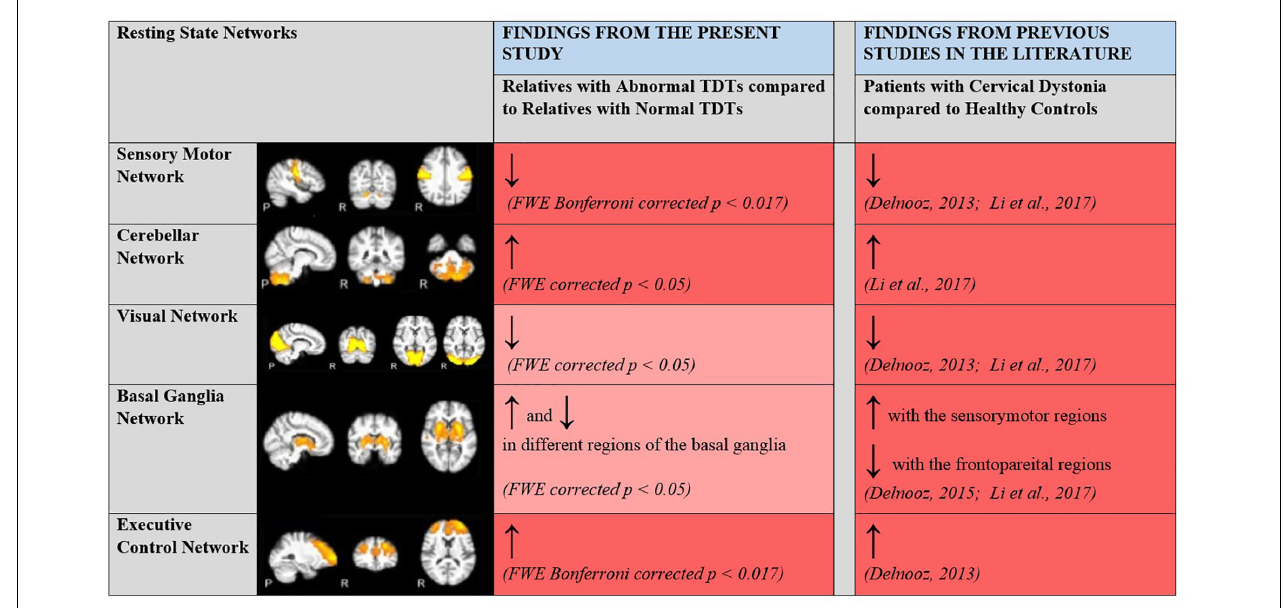
FIGURE 5 | Changes in within network functional connectivity in relatives with abnormal TDT when compared to relatives with normal TDT. Comparative analyses with previous rsfMRI connectivity studies carried out with patients with CD and healthy controls. ↑ , Increased connectivity; ↓ , Decreased connectivity; Dark Red, Significant changes in functional connectivity, ReHo and ALFF; Light Red, No significant changes in functional connectivity detected via the ICA method but significant changes in regional coherence (ReHo) and power (ALFF) detected. Resting State Networks shown adapted from Castellazzi et al. (2014).